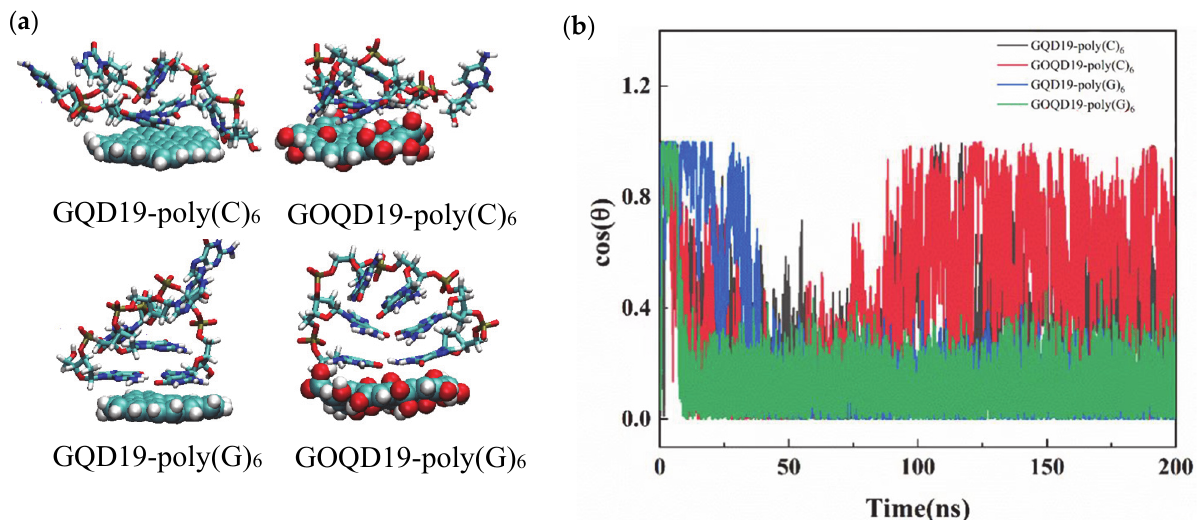
Figure 2. ( a ) Representative snapshots of ssDNA adsorption on GQD19 and GOQD19 surface at the end of the 200 ns MD simulation. ( b ) The curve of the angle between the ssDNA axis vector and the normal vector of the GQD19 (GOQD19) plane during the simulation.